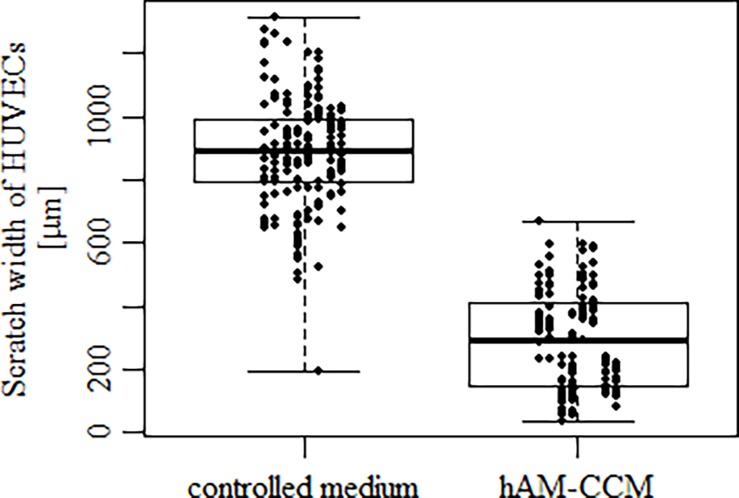
Effect of hAM CCM on HUVECs migration assayed by scratch test.There are results of 160 measurements, 8 independent assays with 10 measurements for test and control each. Median values and (P25, P75) are shown (n = 8, p < 0.05). Detailed description of the assay is in Material and methods.